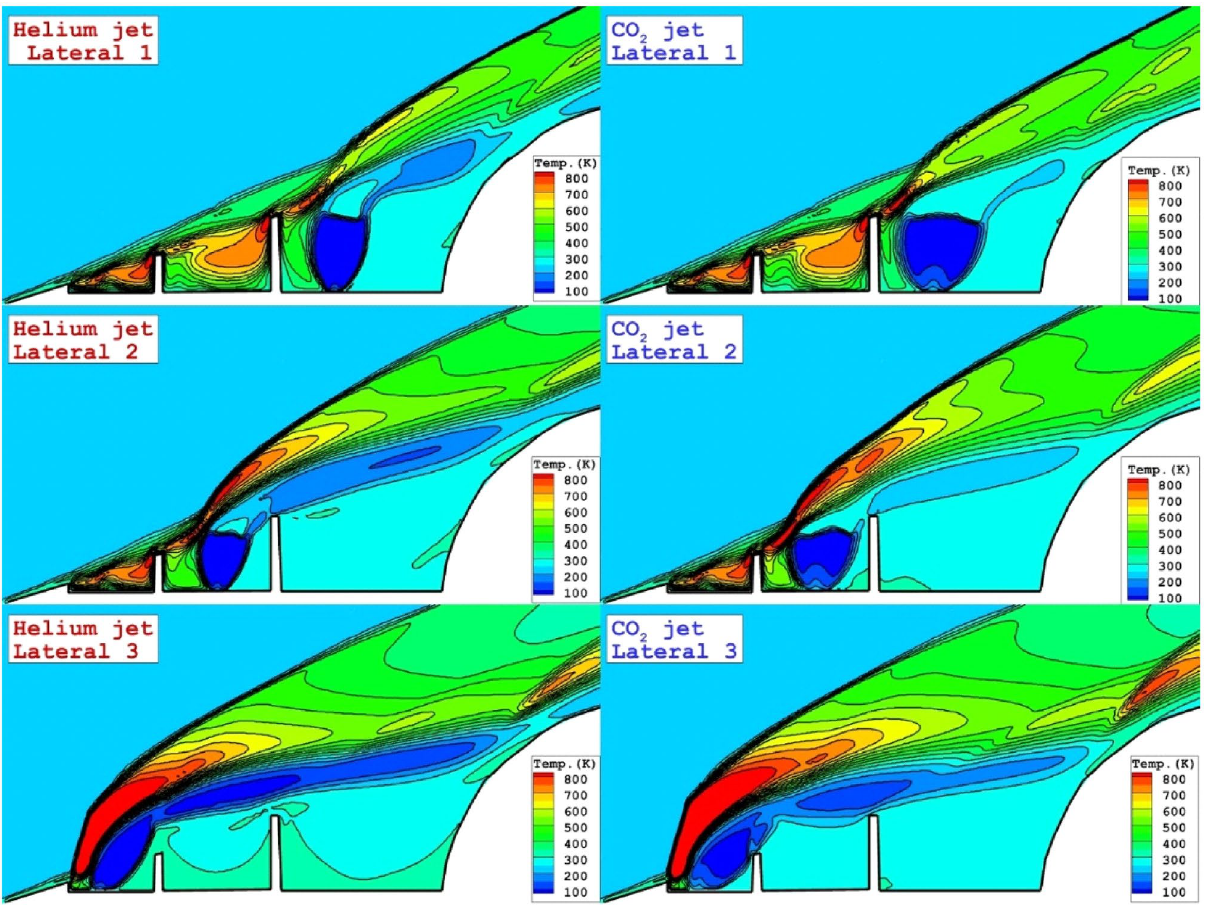
Figure 6. temperature distributions nearby the main body for the different lateral coolant injection